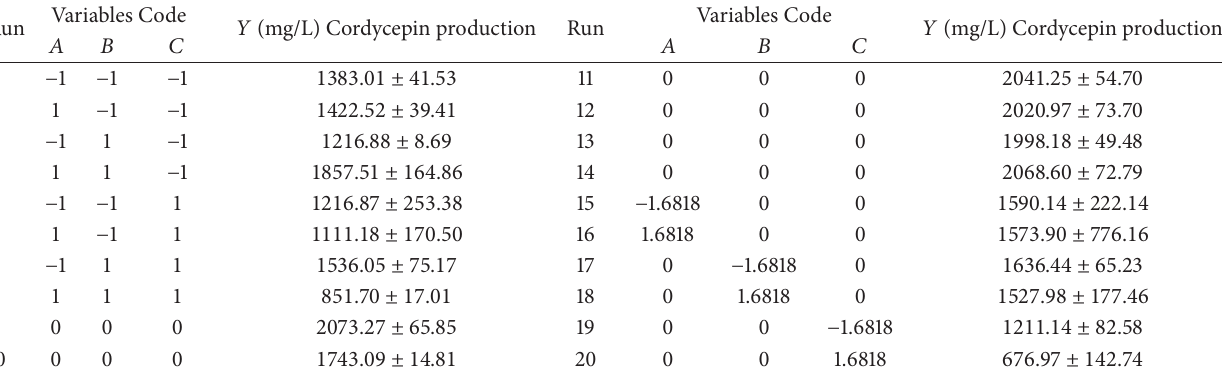
Table 8: Experimental design and responses of the central composite design for amino acid, nucleoside analogue, and